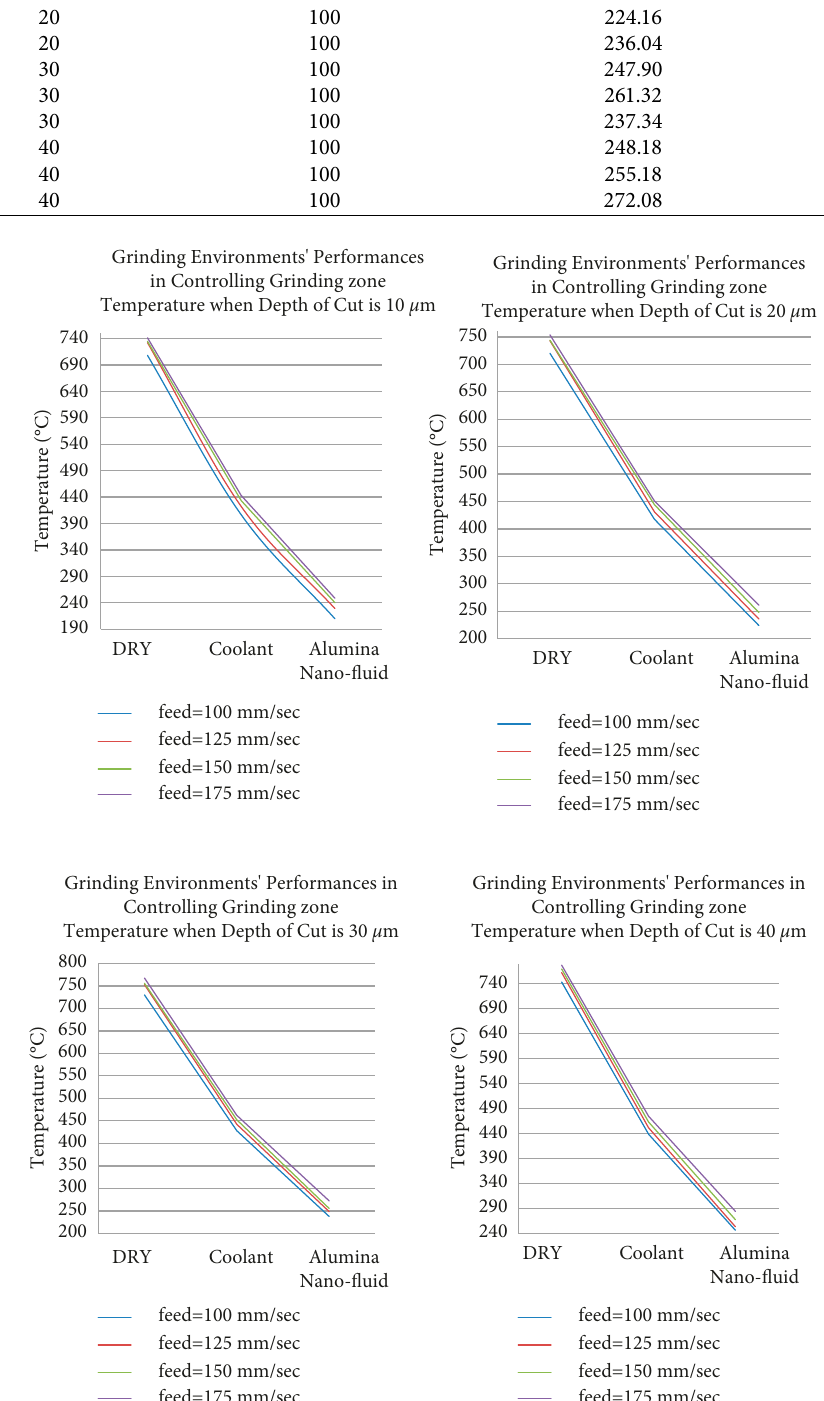
Figure 1: Grinding environments’ performances in downsizing the cutting zone temperature in constant depth of cut and various